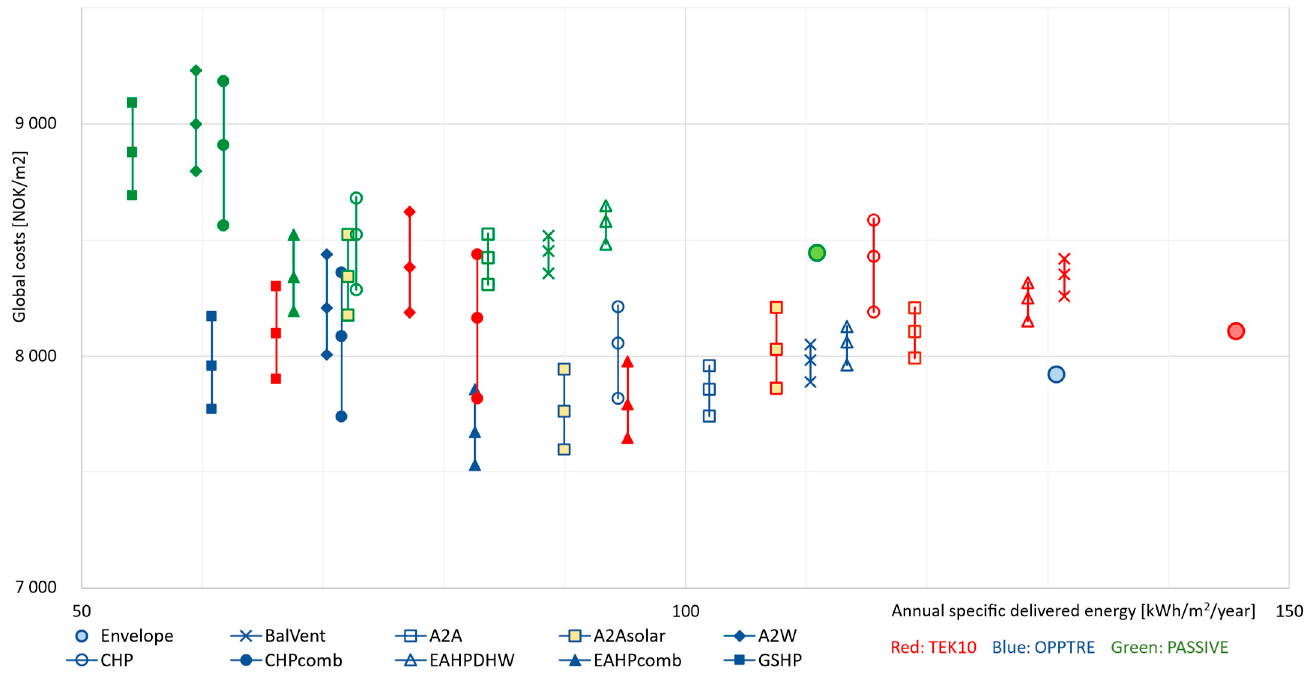
Figure A4. Specific global costs and delivered energy of the Malvik house with government grants included and electricity price of 2.0 NOK/kWh.